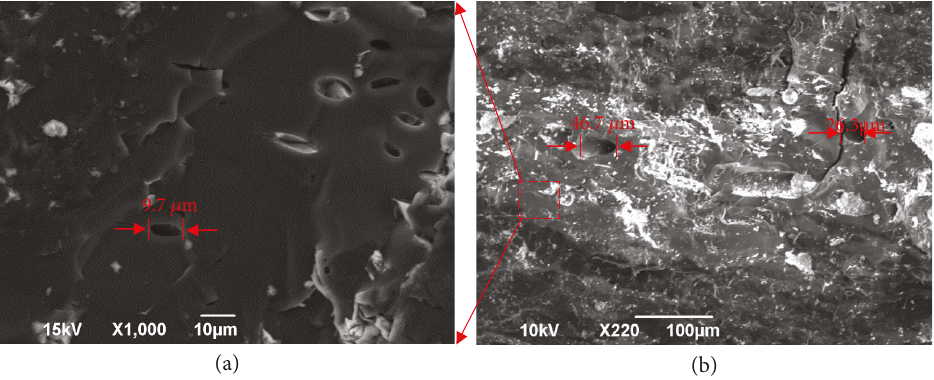
Figure 6: SEM images showing the porous structure of easy-to-drain